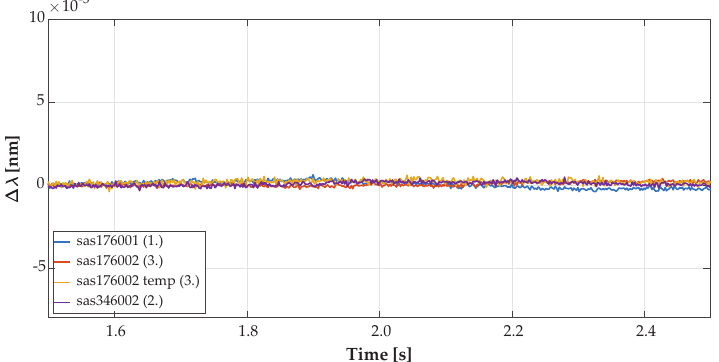
Figure 9. Record detail of axle detection from horizontal FBG sensors from the overpassing vehicle with a non-optimal traffic line as reflected in the optical spectrum wavelength change detected by the